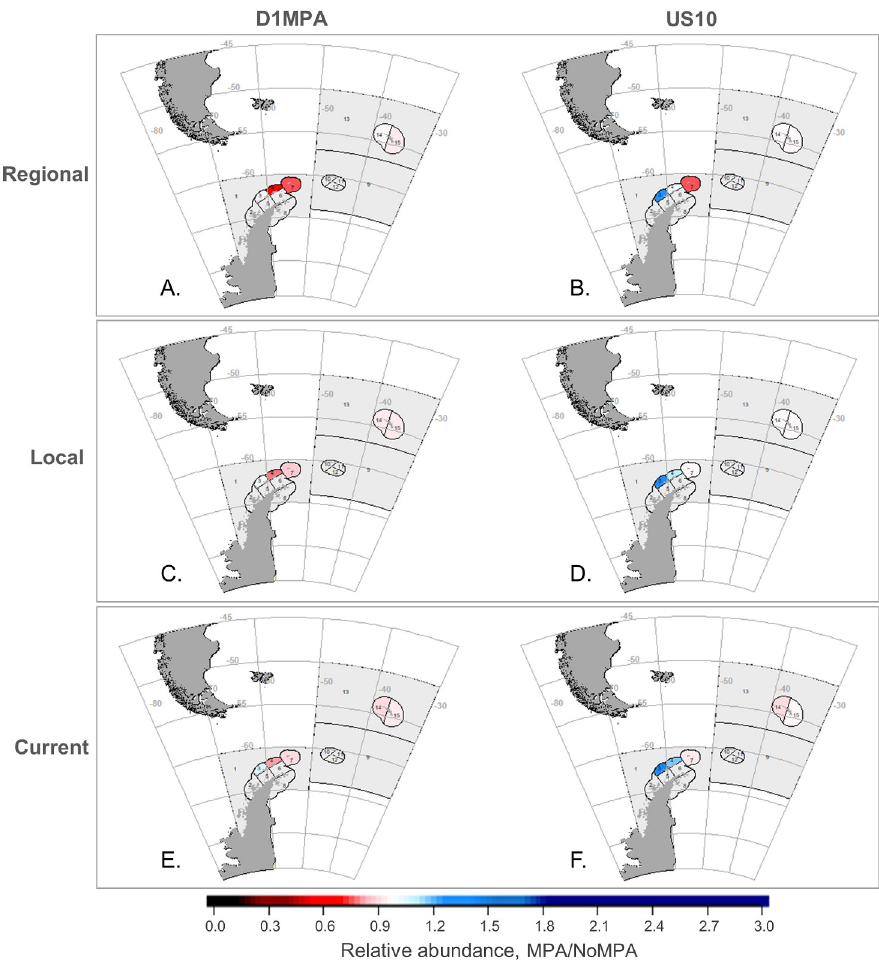
Fig 5. Outcomes for seals by SSMU in both MPA scenarios. Change in seal abundance with the MPA relative to the No MPA scenario (i.e. MPA/No MPA); all other details as in Fig 4. forage are closed to the krill fishery. To answer this question, we compared the percentage of predator foraging that occurred within closed areas in each MPA (Table 1) to the changes in relative abundance of predator populations (i.e., abundance in the final year of the MPA sce- nario relative to abundance in the final year of the No MPA reference). Generally, our results showed that abundance of all predator groups was likely to be higher when foraging occurred inside an MPA during the summer breeding season (Fig 7; we did not report patterns for the winter season as many predators depart to forage outside the model arena [45]). For most of the groups, differences between the MPA scenarios depended upon which scenario protected the largest foraging area. For penguins, the D1MPA (circles in Fig 7) saw greater increases than US10 (triangles in Fig 7) since it protected a greater proportion of the birds’ foraging areas. The opposite was true for seals and whales, whose foraging distributions were more pro- tected foraging under US10 than the D1MPA. For seals, a small increase in foraging protection in US10 over the D1MPA in some SSMUs (Table 1) still returned a greater seal abundance. In contrast, while relative fish abundance also increased with an increase in protected foraging areas, no difference appeared between the two MPA scenarios. Notably, many increases in